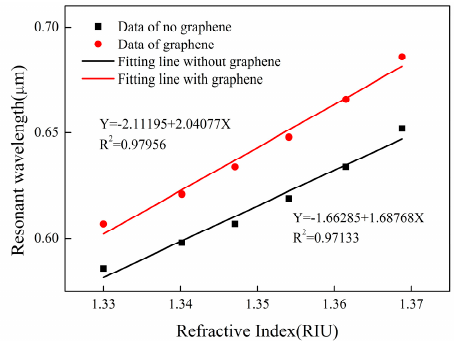
Figure 5. Comparison of sensor fitted lines with or without graphene.